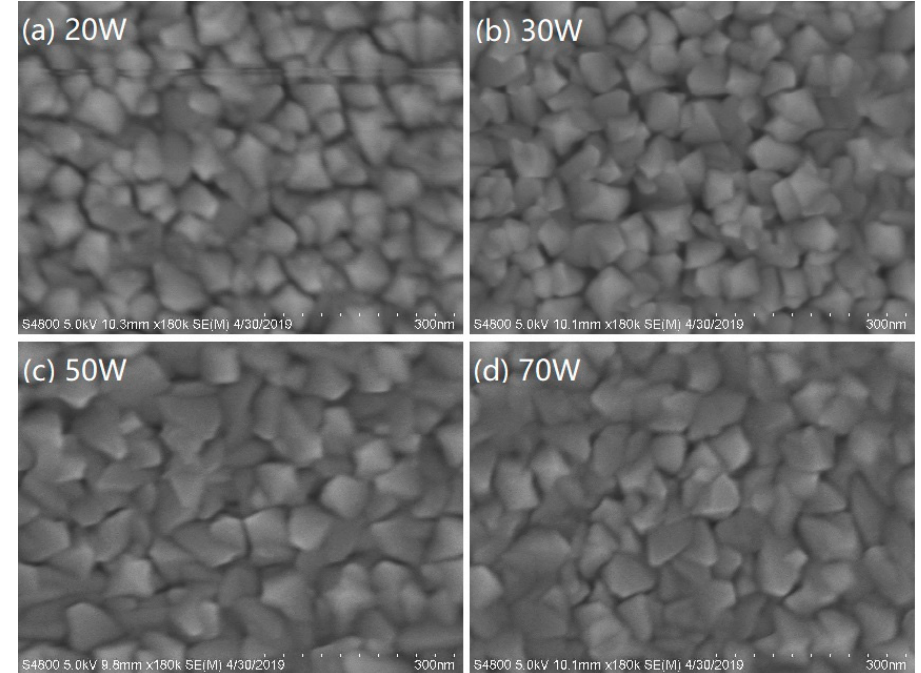
Figure 1. SEM images of the Bi 2 Te 3 films deposited under di ff erent